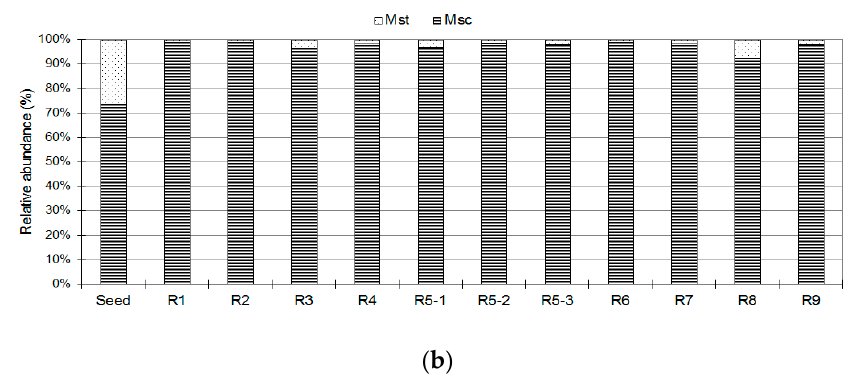
Figure 4. Profiles of Archaea (ARC), Methanosarcinaceae (Msc), and Methnosaetaceae (Mst) at different conditions ( a ) and the relative abundance of Msc and Mst ( b ).